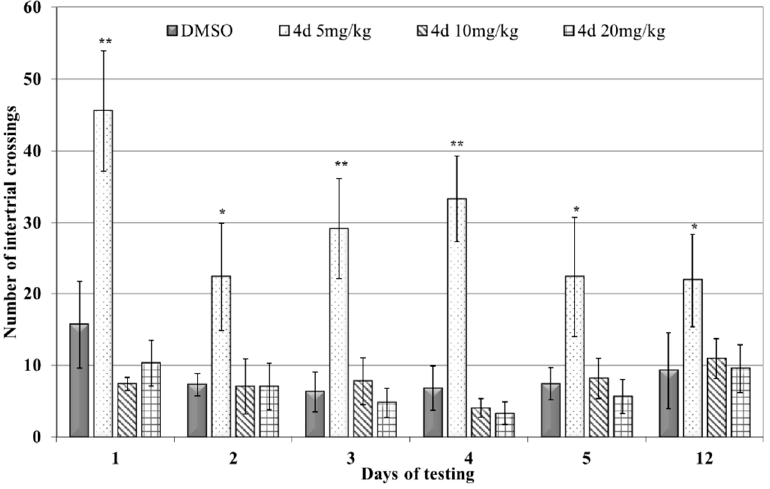
Figure 6. Effects of 4d on learning and memory processes in rats (shuttle-box active avoidance test, number of intertrial crossings) * p < 0.05 compared with the same-day control group; ** p < 0.01 compared with the same-day control group.